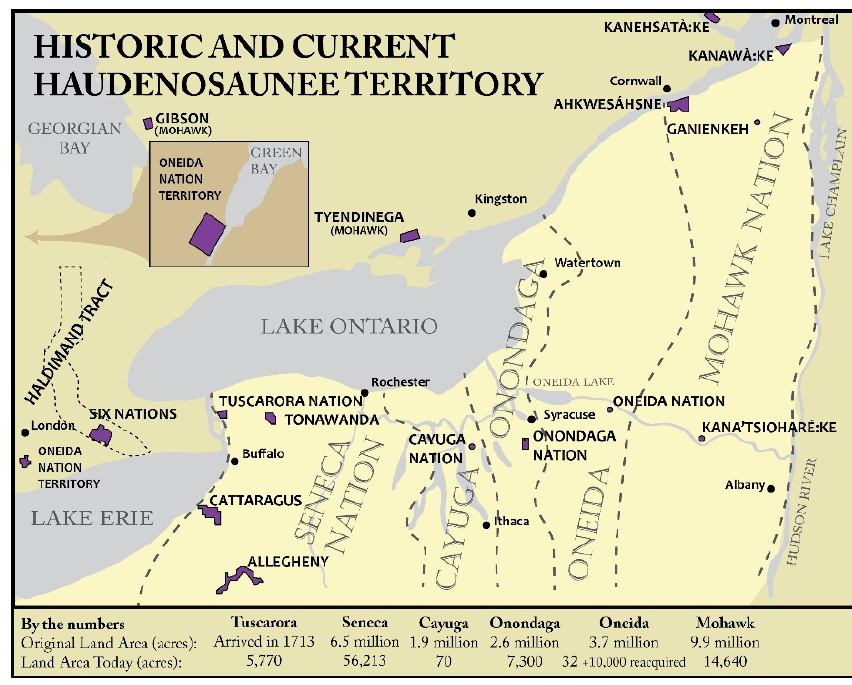
Source: Two Row Wampum Renewal Campaign,